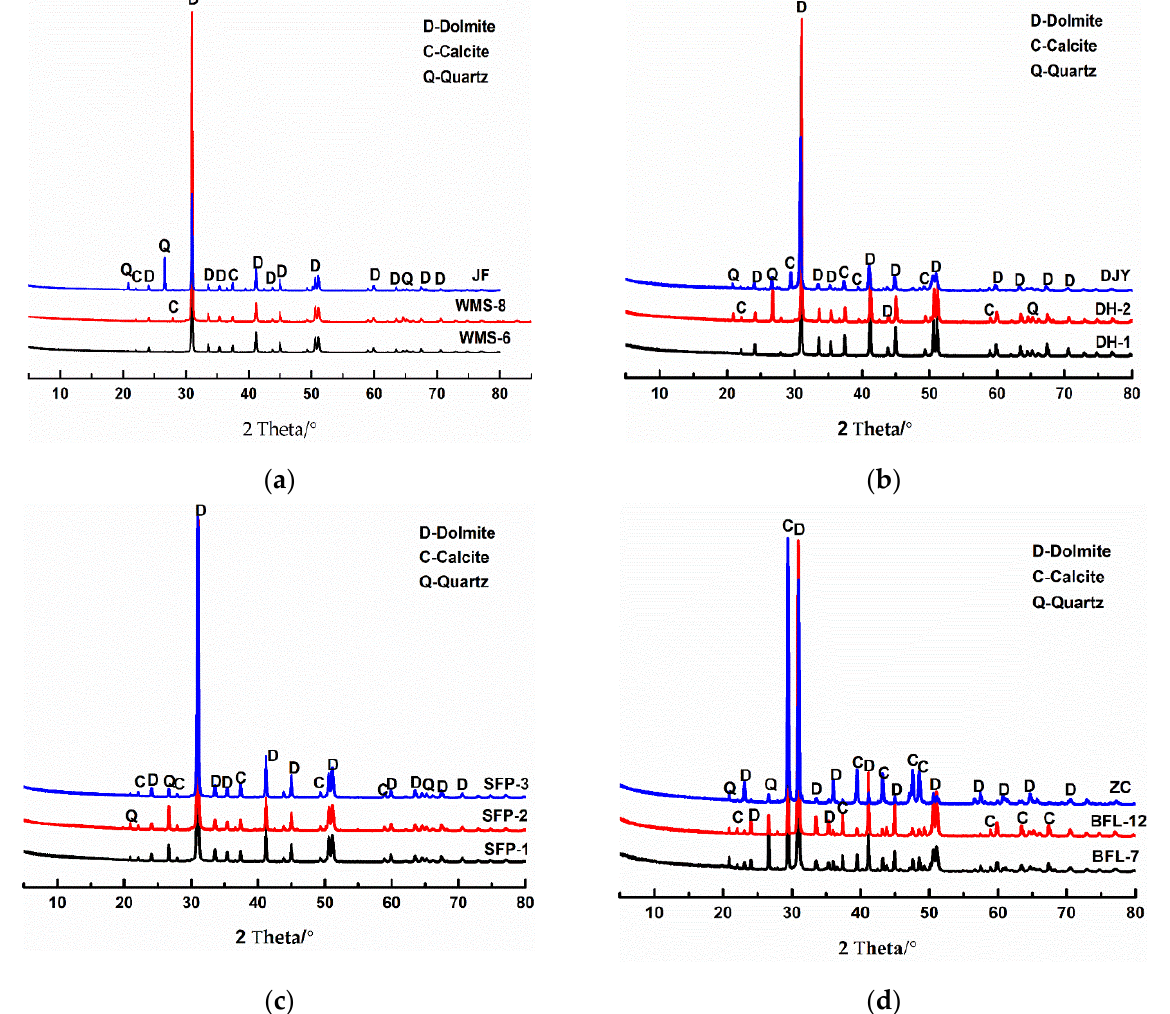
Figure 2. XRD patterns of rocks: ( a – c ) dolomite; ( d ) dolomitic limestone.